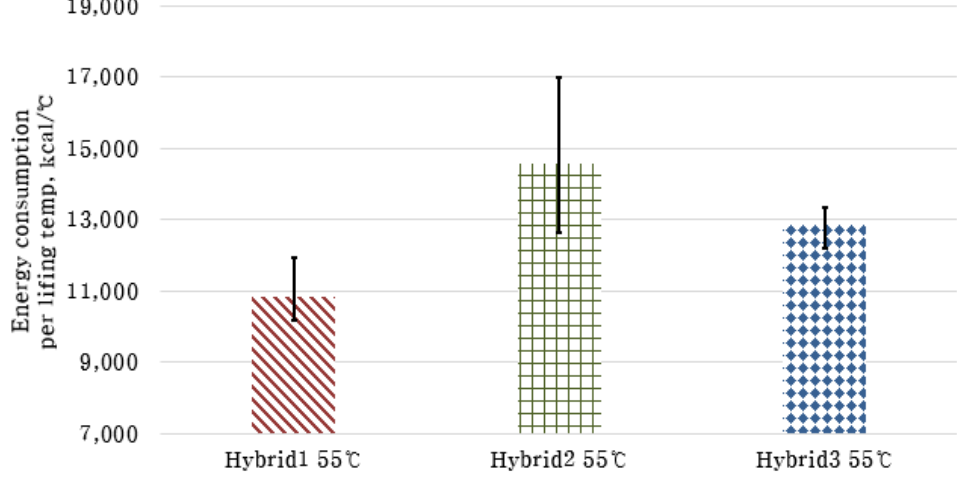
Figure 11. Comparison of energy consumption as a function of increasing temperature. Table 7. Results of the statistical analysis of energy consumption as a function of increasing temperature. Duncan